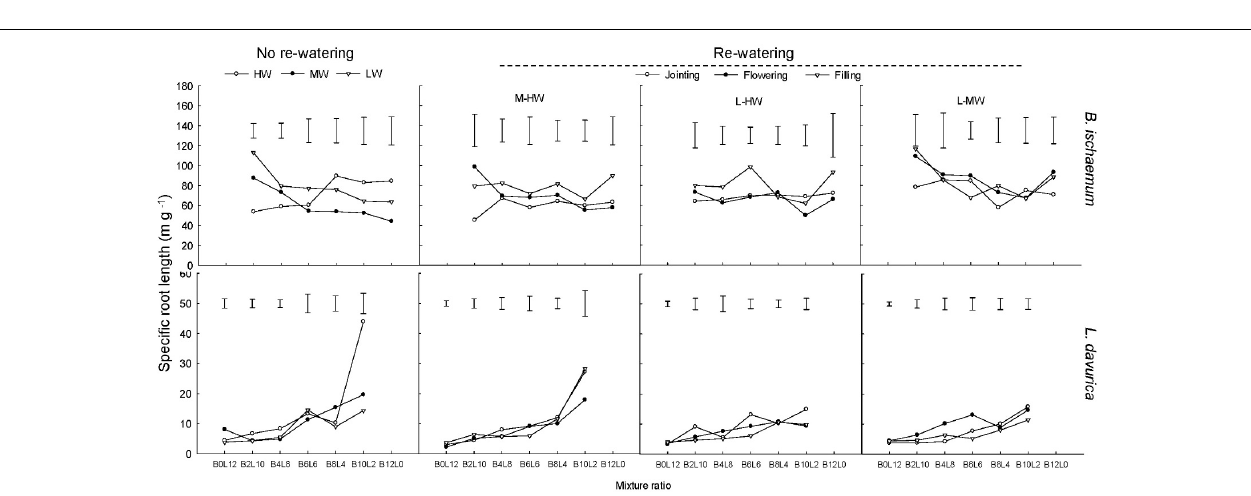
FIGURE 4 | Root surface area (RSA) per plant of B. ischaemum (B) and L. davurica (L) at various mixture ratios under each water treatment. HW: 80 ± 5% FC; MW: 60 ± 5% FC; LW: 40 ± 5% FC; M-HW: soil water content increased from MW to HW; L-MW: soil water content increased from LW to MW; L-HW: soil water content increased from LW to HW. The vertical bars indicate the LSD values ( P ≤ 0.05) for the RSA difference of each species among water treatments at each mixture ratio.